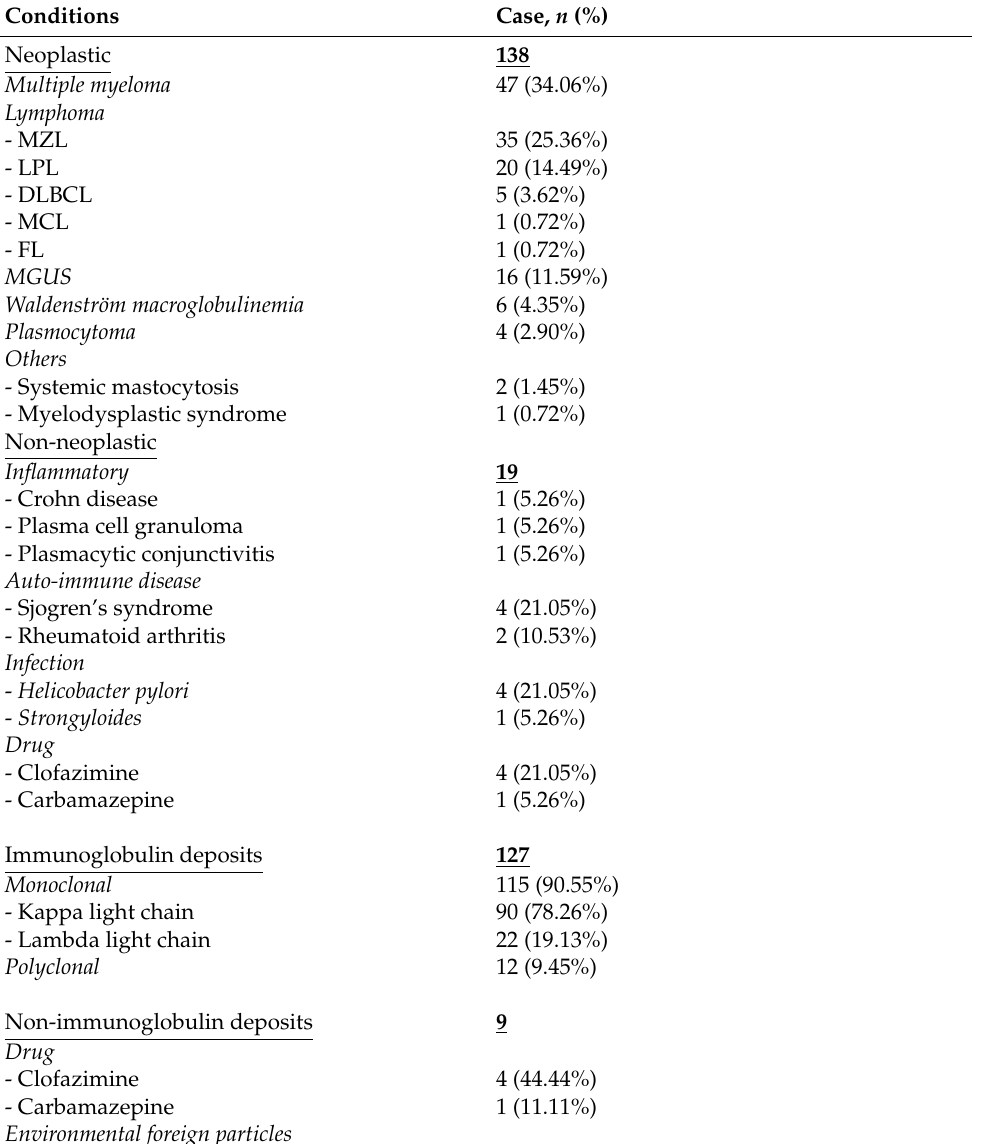
Table 2. Conditions associated with crystal-storing